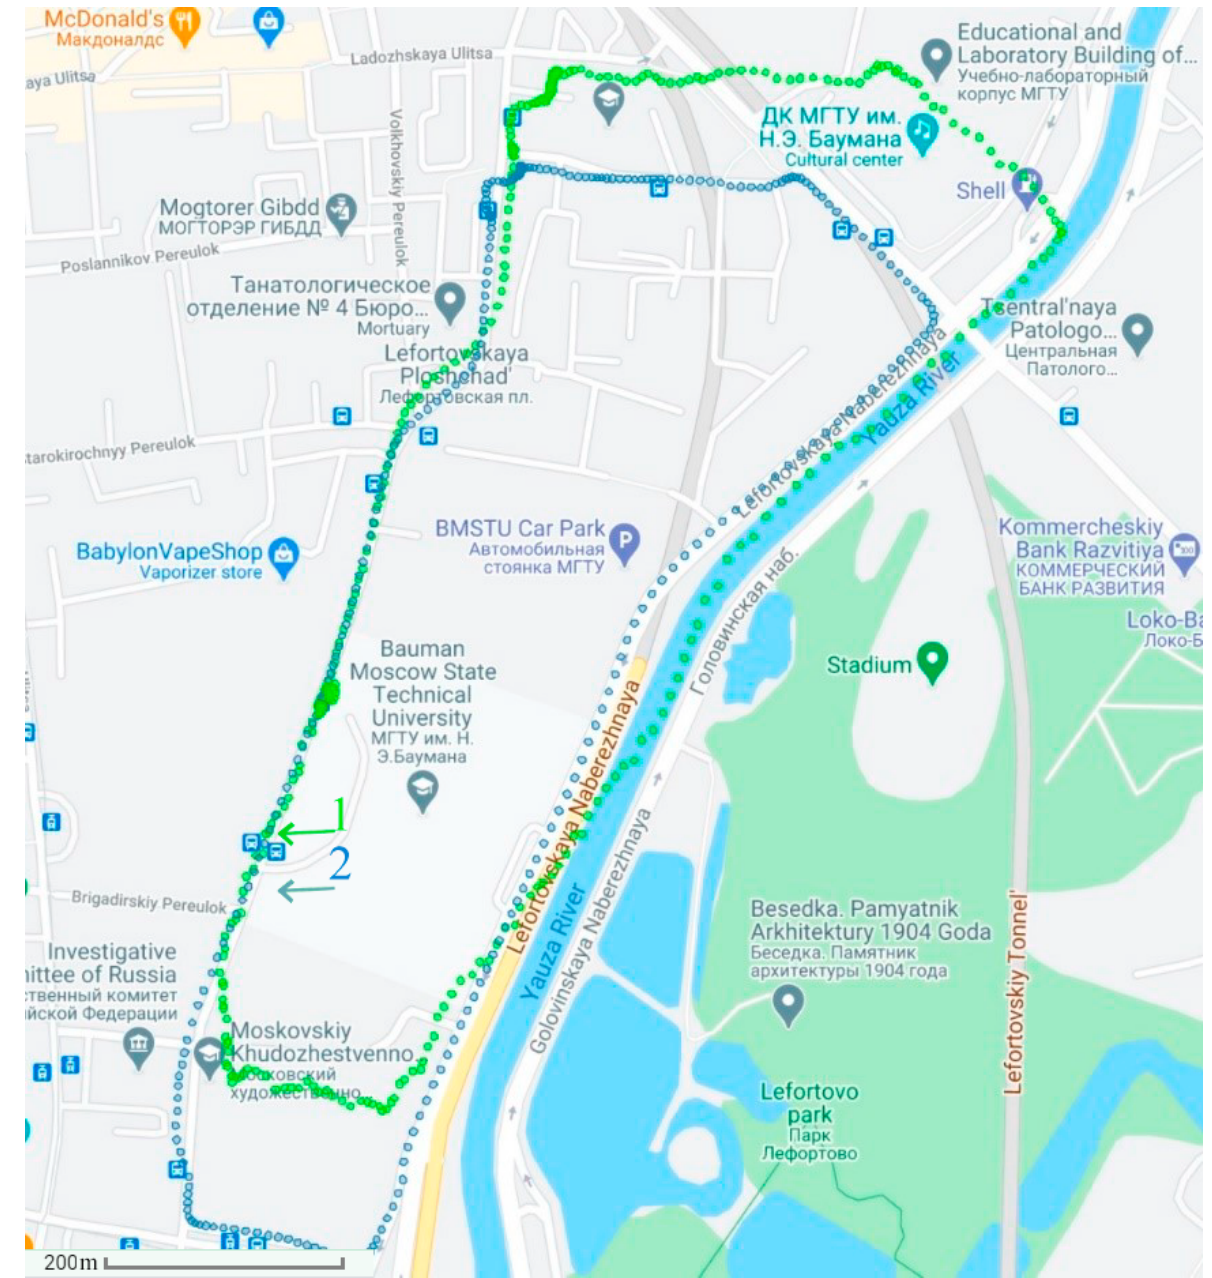
Figure 6. The positioning results of the SINS corrected by the GNSS (containing 40% abnormal measurements) using the KF: 1—positioning results; 2—actual